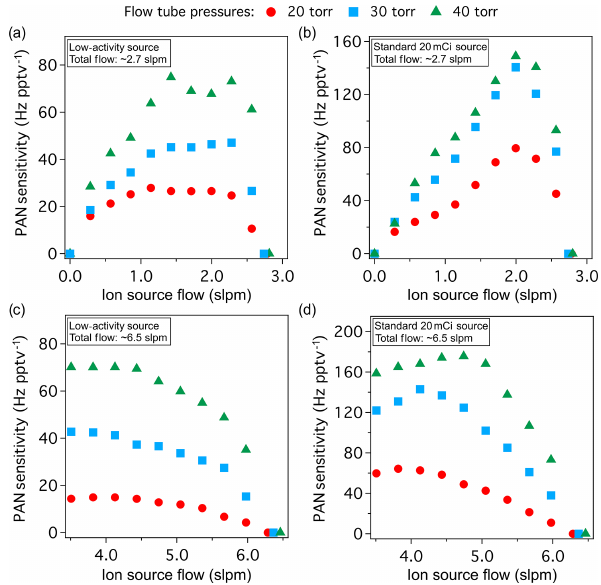
Figure 3. The sensitivity (Hzpptv − 1 ) of the LAS and a standard source for PAN ( m/z 61) at different flow tube pressures and total flows, plotted as a function of ion source flow. The ages of the LAS and the standard source used here are approximately 2 and 4 months old, respectively. (a) PAN sensitivity using the LAS and (b) the stan- dard source at total flow of ∼ 2 . 7slpm. (c) PAN sensitivity using the LAS and (d) the standard source at total flow of ∼ 6 . 5slpm. Red circles, cyan squares and green triangles correspond to flow tube pressures of 20, 30 and 40torr,